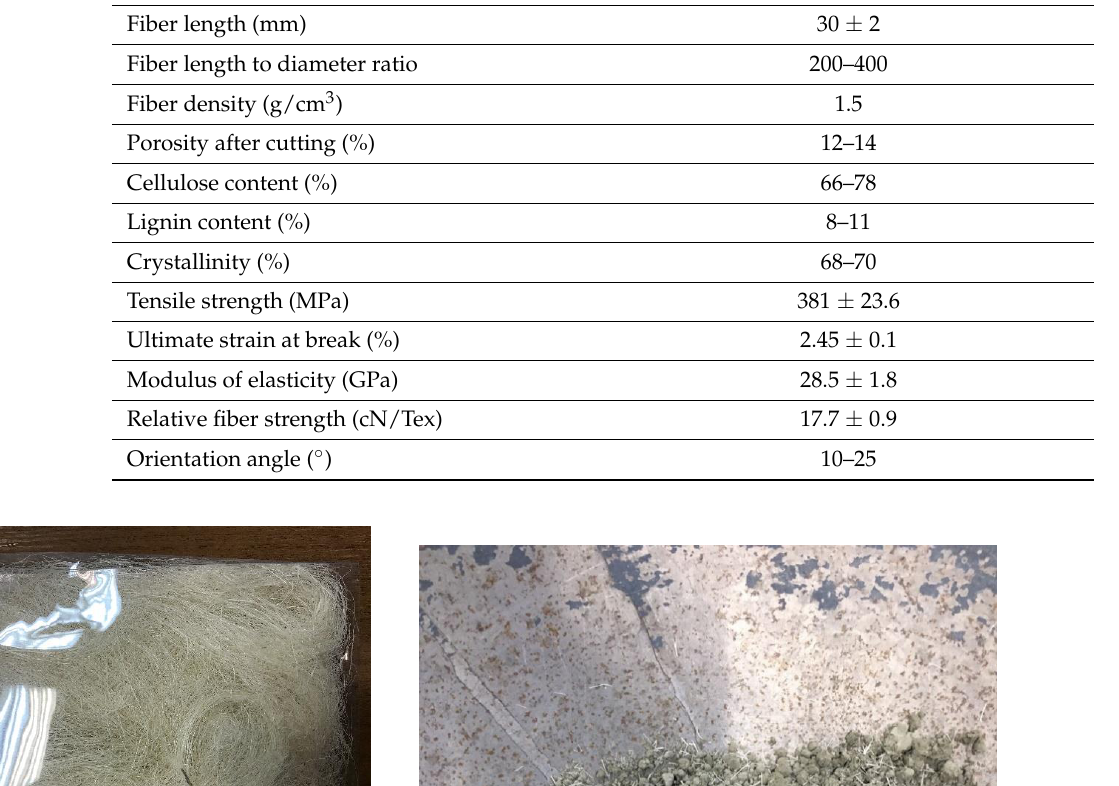
Table 2. Characteristics of sisal fiber.